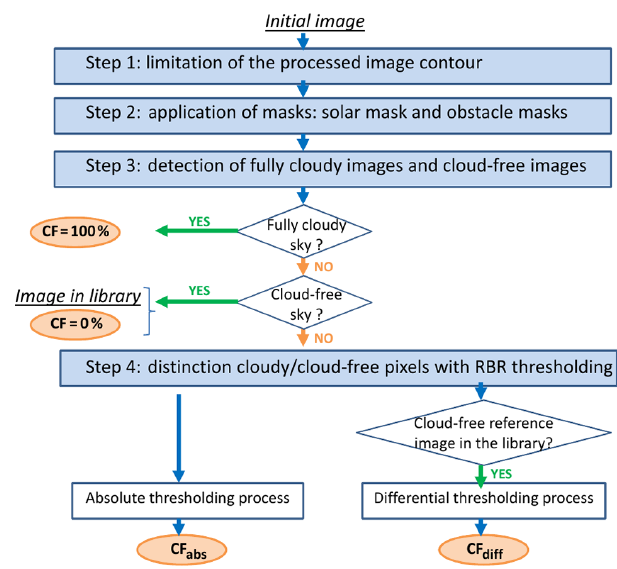
Figure 4. Organigram of the various steps in the image processing procedure. CF abs is the cloud fraction deduced from the absolute thresholding process, and CF diff is the cloud fraction deduced from the differential thresholding